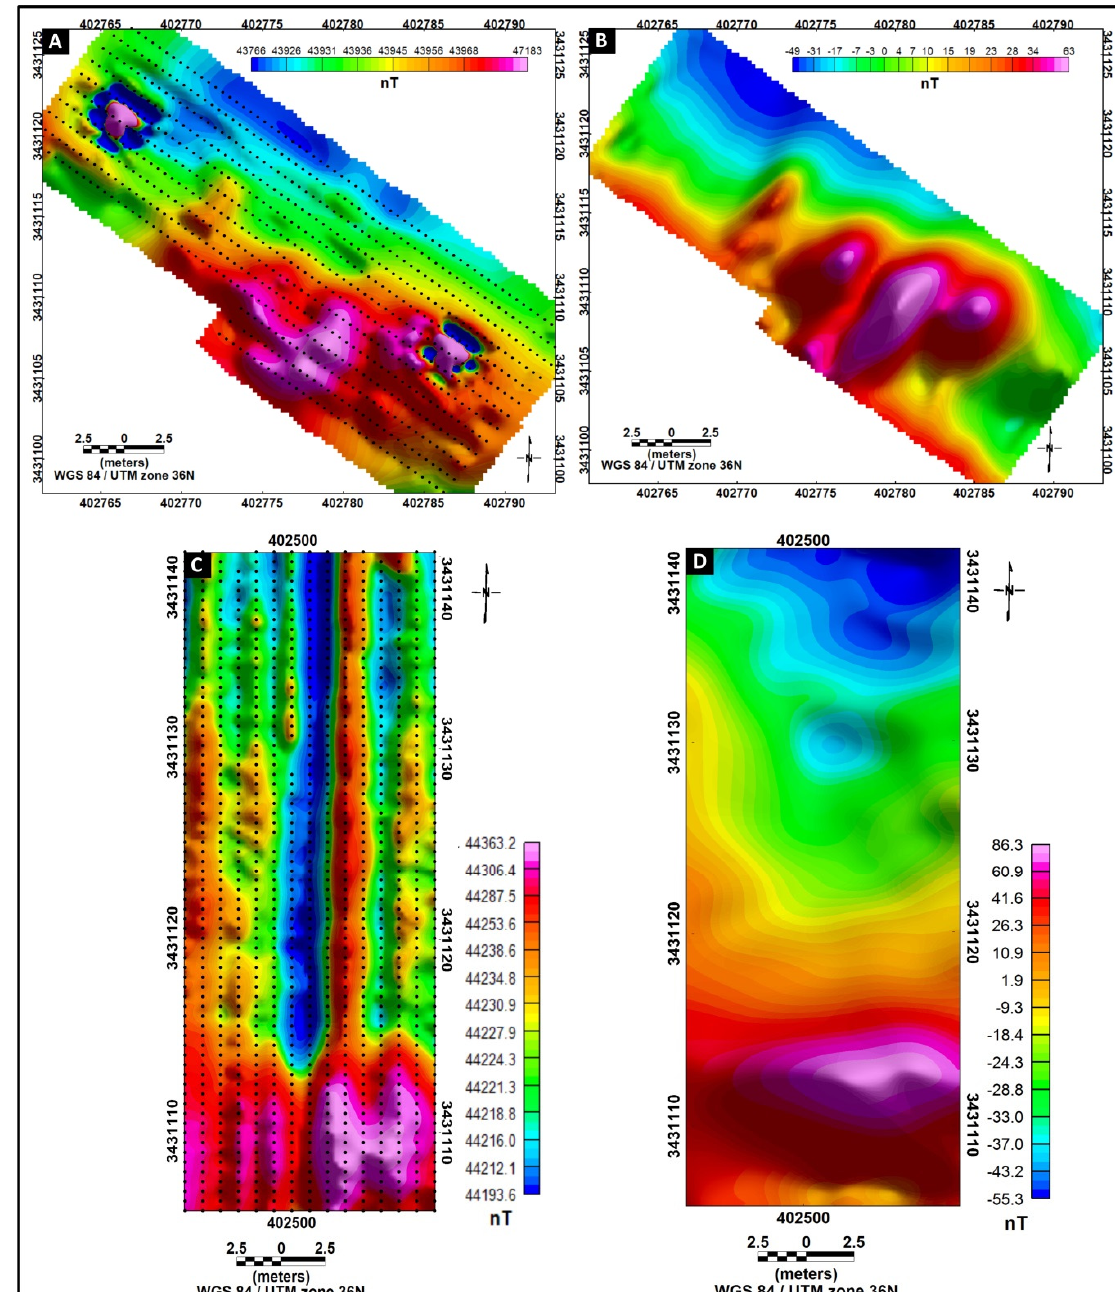
Figure 5. Examples of magnetic data processing: (A, B) original and processed magnetic maps at Site B, respectively; and (C,D) original and processed magnetic maps at Site C, respectively.